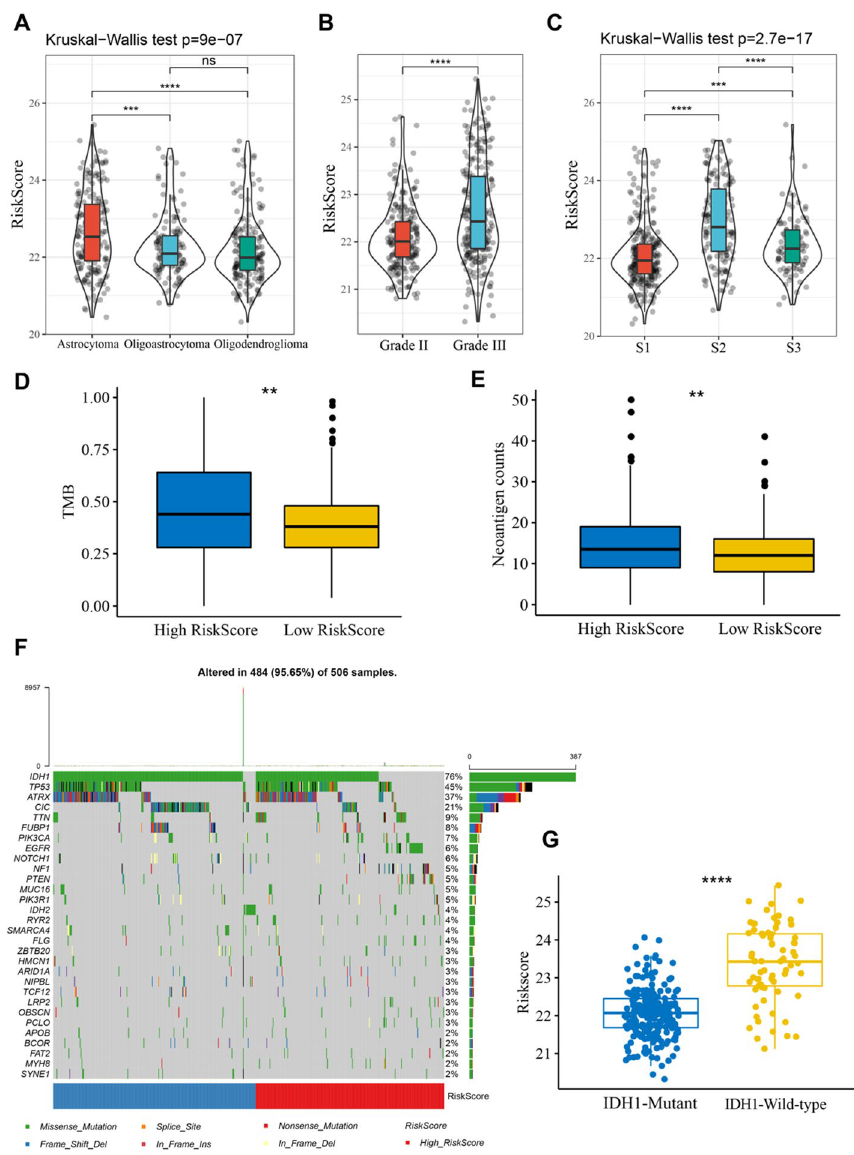
Fig. 8 Clinical and mutational characteristics of RRG-related RiskScore. a Differences in RRG-related RiskScore between astrocytomas, oligoastrocytomas and oligodendrogliomas. The differences between every two groups were compared through the Kruskal–Wallis test. b Differences in RRG-related RiskScore between grade II and grade III tumor. The difference was compared through the Kruskal–Wallis test. c Differences in RRG-related RiskScore between subtype 1, subtype 2 and subtype 3. The differences between every two groups were compared through the Kruskal–Wallis test. d , e Differences in TMB ( d ) and neoantigen counts ( e ) between high- and low-RiskScore groups. The difference was compared through the Kruskal–Wallis test. f The top 30 frequently mutated genes in high- and low-RiskScore groups. g Differences in RiskScore between IDH1-mutant and IDH1-wild-type groups. The difference was compared through the Kruskal–Wallis test. ** P < 0.01, *** P < 0.001, **** P <